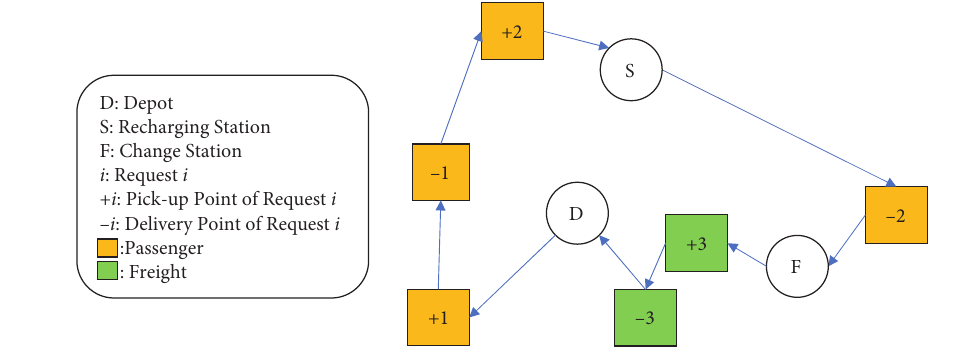
Figure 3: An example of a vehicle route.